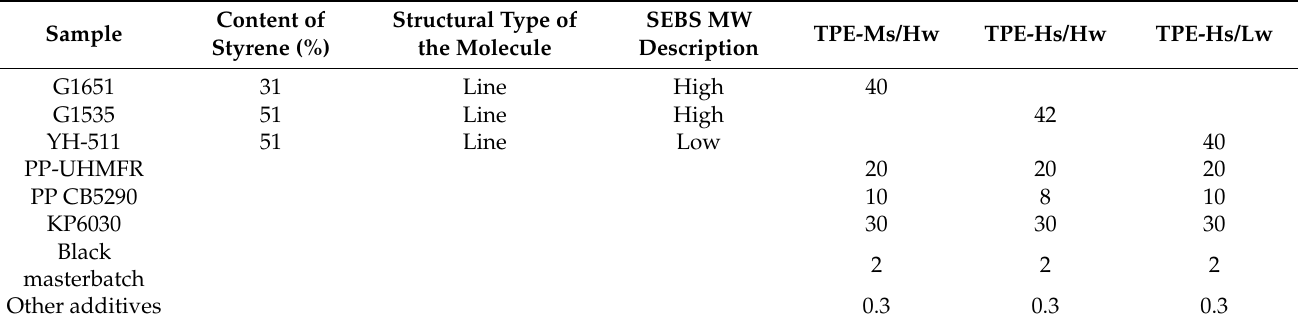
Table 4. Formulas of TPE prepared by SEBS with various styrene